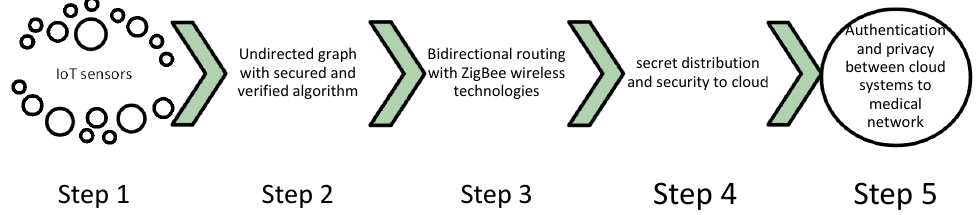
Figure 1. The research components of the proposed network-reliable approach with security.